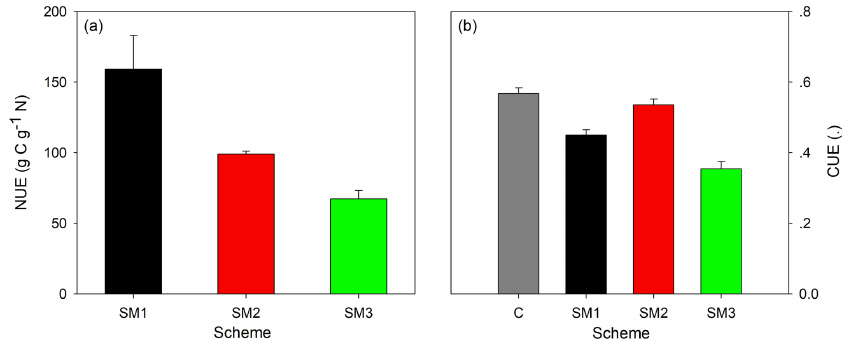
Figure 6. The nitrogen use efficiency (NUE, a ) in three C–N schemes of the TECO model (SM1, SM2, and SM3) and the carbon use efficiency (CUE, b ) at the steady state among the C-only version and the three C–N schemes of the TECO model (SM1, SM2, and SM3).